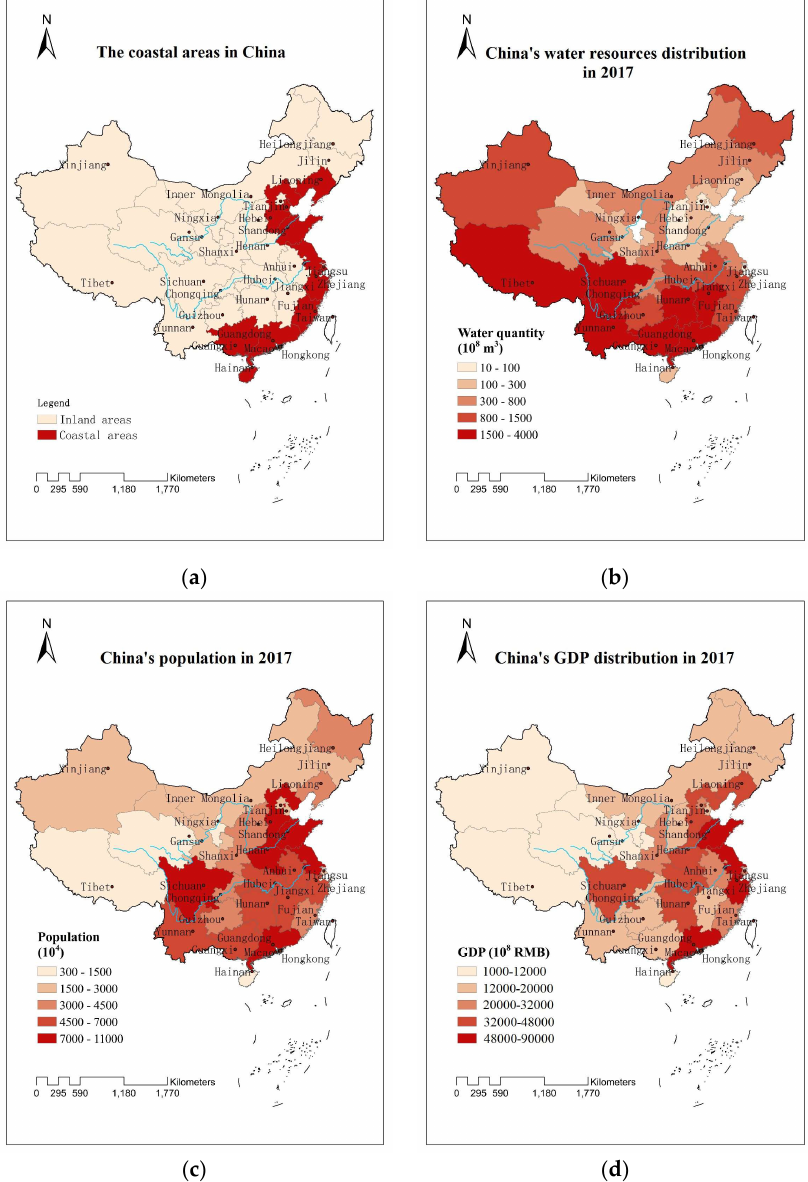
Figure 1. The distribution of regional water resources, population and GDP in China. ( a ) Description of the coastal areas in China; ( b ) description of China’s water resource distribution in 2017; ( c ) description of China’s population in 2017; ( d ) description of China’s GDP distribution in 2017. The data source for Figure 1a,c,d is China Statistical Yearbook, released by the National Bureau of Statistics, China [22]. The data source for Figure 1b is China Water Resources Statistical Yearbook, released by China Ministry of Water Resources of People’s Republic of China